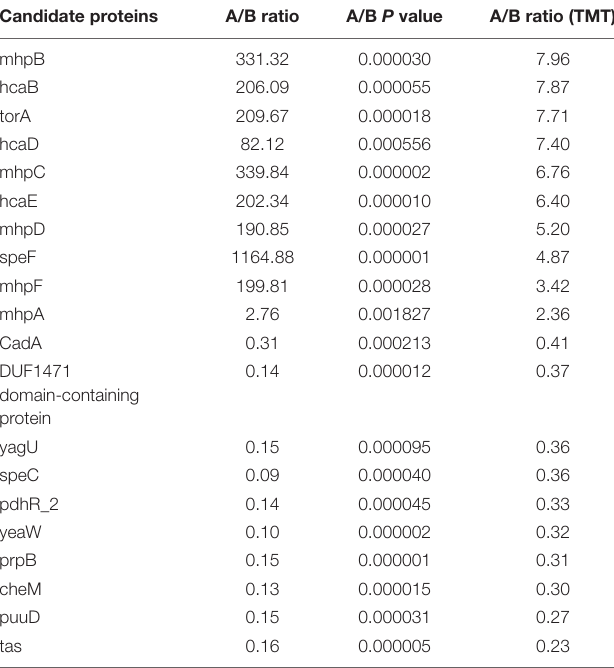
TABLE 4 | PRM analysis of 20 candidate proteins.